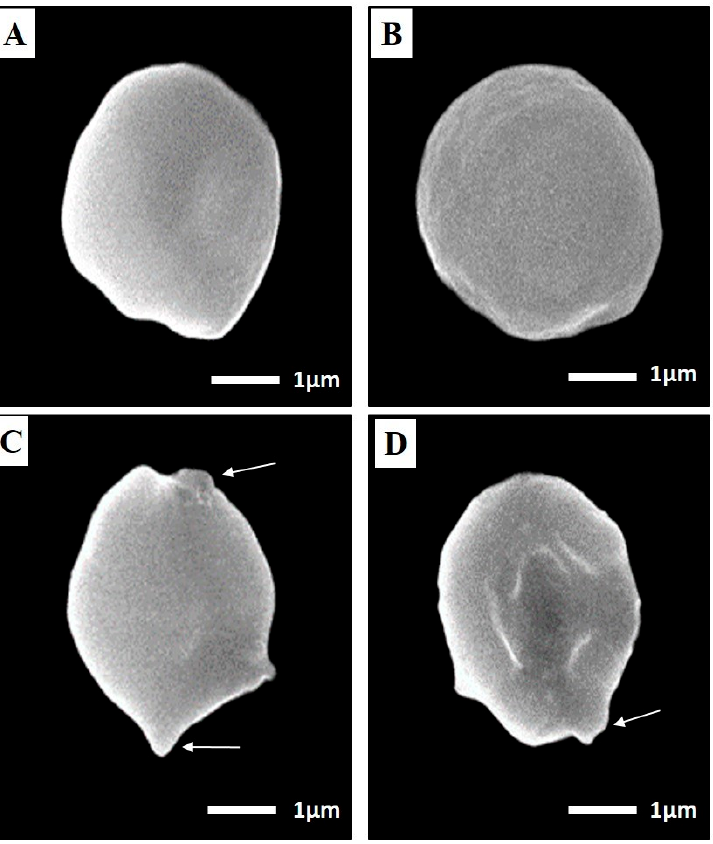
Figure 7. SEM of T. gondii cyst harvested from the infected control group (I); ( A ) mice vaccinated with TLA (group III); ( B ) mice vaccinated with TLA/MLT-SLNs (group V) ( C , D ). ( A ) Cysts harvested from the control group showed regular spherical-shaped bodies with some fine dimples and indentations (×12,000). ( B ) Cysts from group III showed mild roughness and surface irregularities with retained spherical outlines (×10,000). ( C , D ) Cysts from group V showed mild swelling and surface irregularities with a focal blebs formation (arrows) (×9500 and ×10,000, respectively).